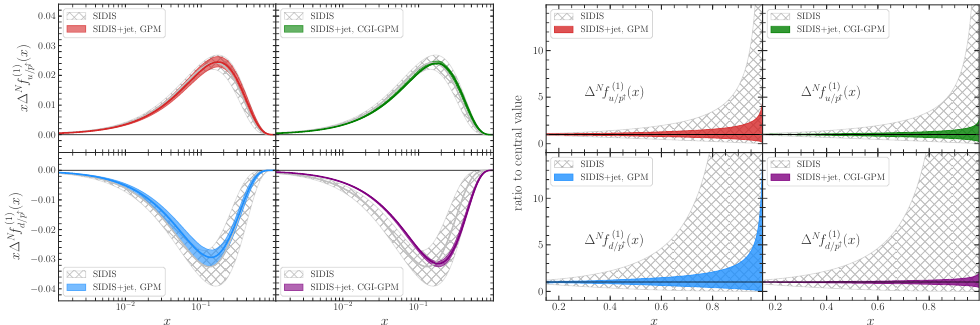
Figure 3: Comparison between the Sivers first k ⊥ -moments (left) and their values normalized to the corresponding central value (right) from SIDIS data and their reweighted SIDIS + jet counterparts in the GPM (left panels) and CGI-GPM (right panels) framework. In both plots, results for u - (upper panels) and d -quarks (lower panels) are shown. Bands correspond to a 2 σ